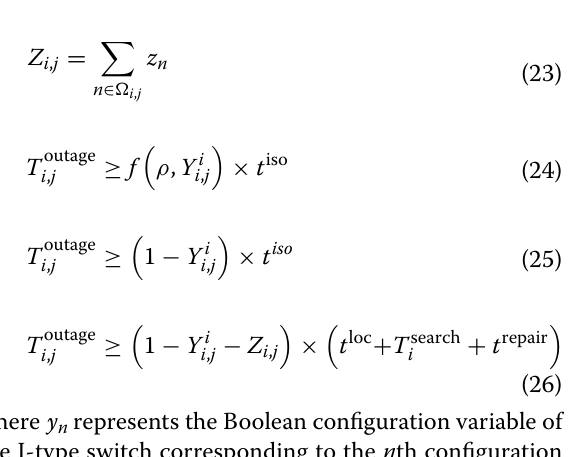
i i , j is the number of I-type (cid:31) (cid:31) i i , j is the set of con- i , j , and (cid:31) i , j .